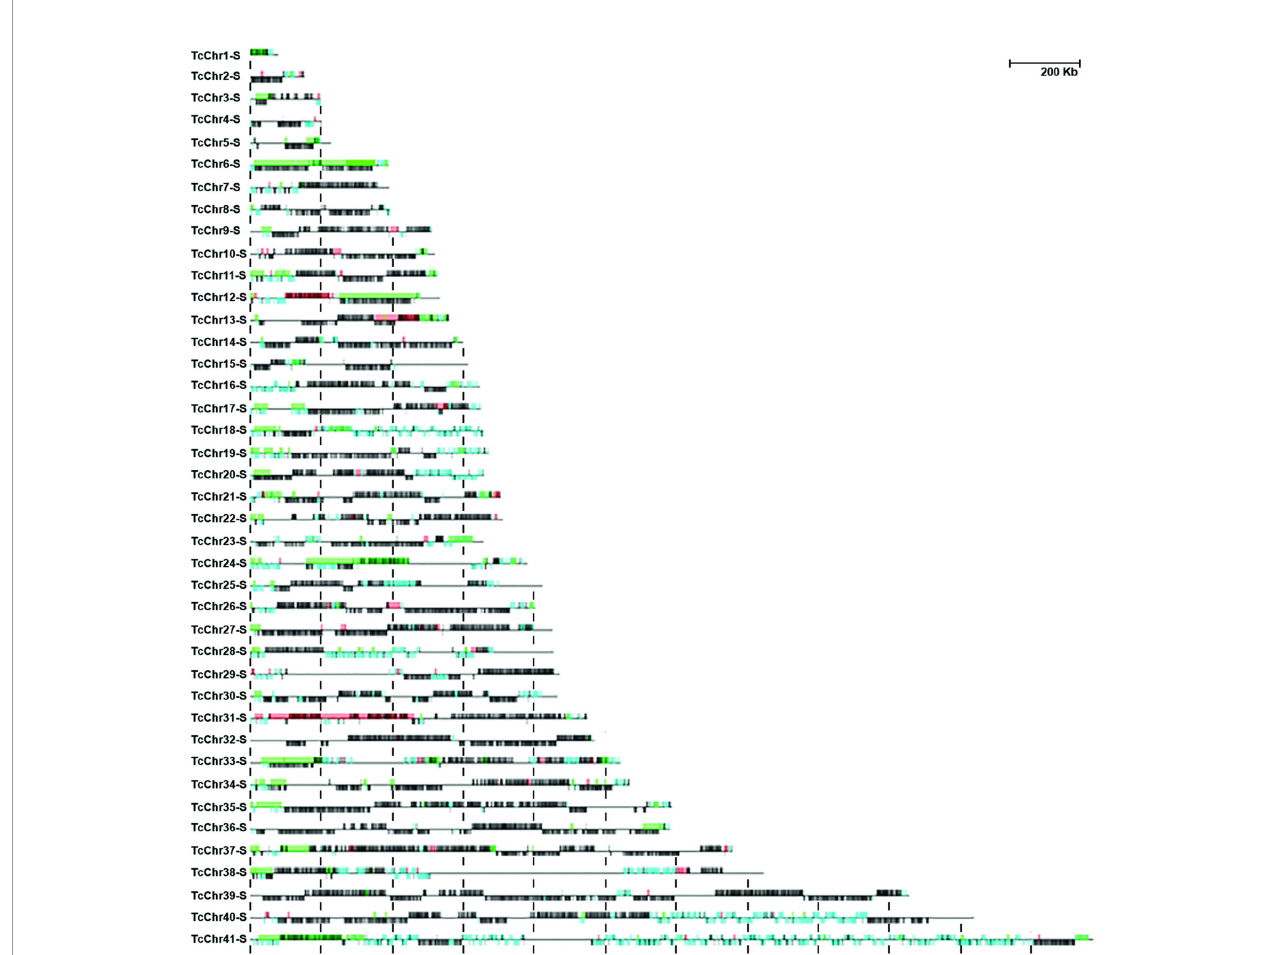
FIGURE 3 | Schematic representation of in silico chromosomes of Esmeraldo-like haplotype showing the gene annotation and chromosomal alterations detected by aCGH in clone D11. Annotation of multigene families in CLB is shown in light blue, and the other genes in black. The CNVs detected by aCGH in clone D11 are shown on the in silico CLB chromosomes. DNA ampli fi cation and deletion are shown in red and green, respectively. Chromosomes and recombination events are shown to scale (Bar=200